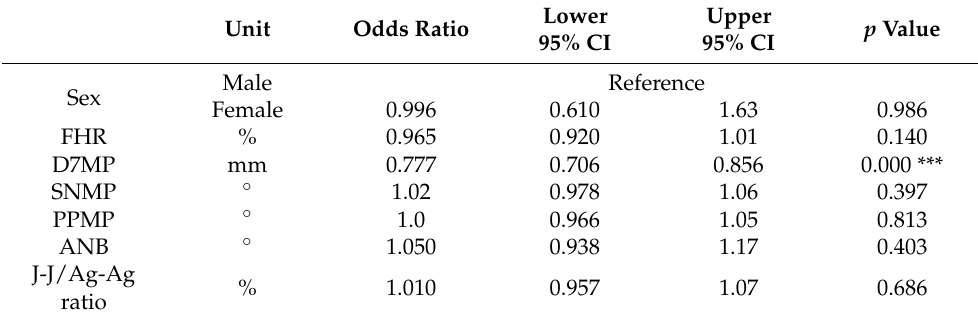
Table 7. Comparison of odds ratio according to the clinical